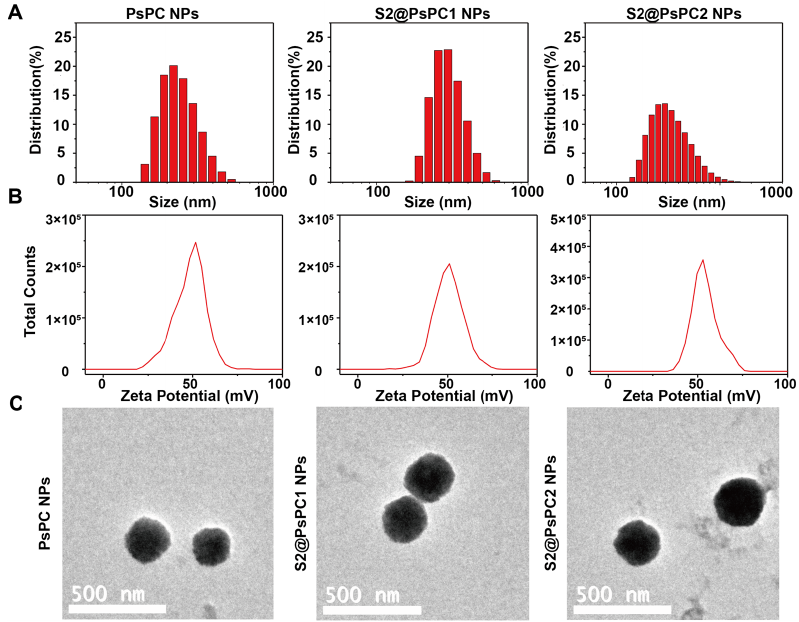
Figure 2. Characterization of PsPC NPs (Blank NPs), S2@PsPC1 NPs, and S2@PsPC2 NPs. The size distribution ( A ) and zeta potential ( B ) were detected by dynamic light scattering (DLS). ( C ) The size of NPs were detected by transmission electron microscopy (TEM). Scale bar indicates 500 nm.